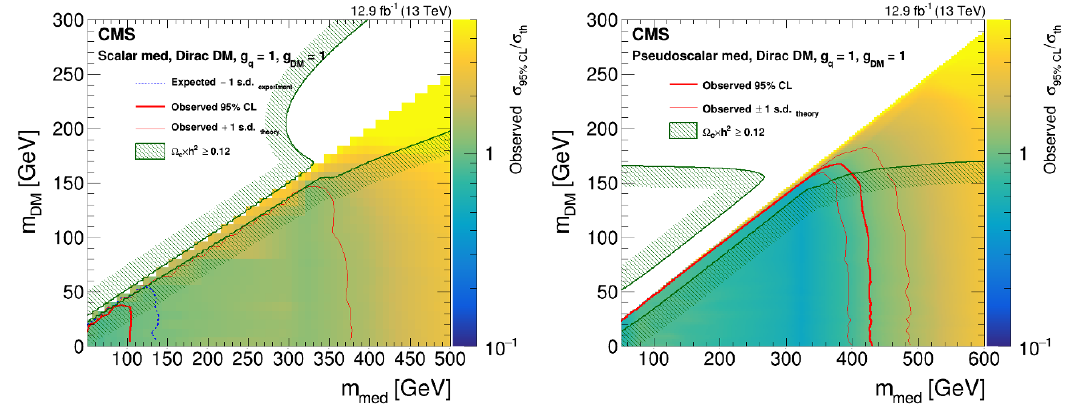
Figure 9 . Exclusion limits at 95% CL on signal strength the (cid:22) = (cid:27)=(cid:27) th in the m med - m DM plane assuming scalar (left) and pseudoscalar (right) mediators. The limits are shown for m med between 50 and 500 GeV, and m DM between 0 and 300 GeV. While the excluded area is expected to extend below the minimum value of m med , the axis does not extend below this value as the signal simulation was not performed in this region. The red line shows the contour for the observed exclusion. The solid red contours around the observed limit represent one standard deviation theoretical uncertainties in the signal cross section. The dashed blue contour in the case of the scalar mediator shows the (cid:0) 1 (cid:27) deviation due to the combination of the statistical and experimental systematic uncertainties. Constraints from the Planck satellite experiment [83] are shown with the dark green contours and associated hatching. The hatched area indicates the region where the DM density exceeds the observed